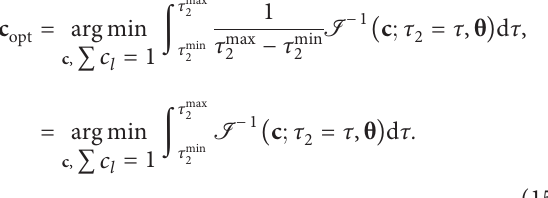
, which affect the gene expression in the model through the rate 2 2